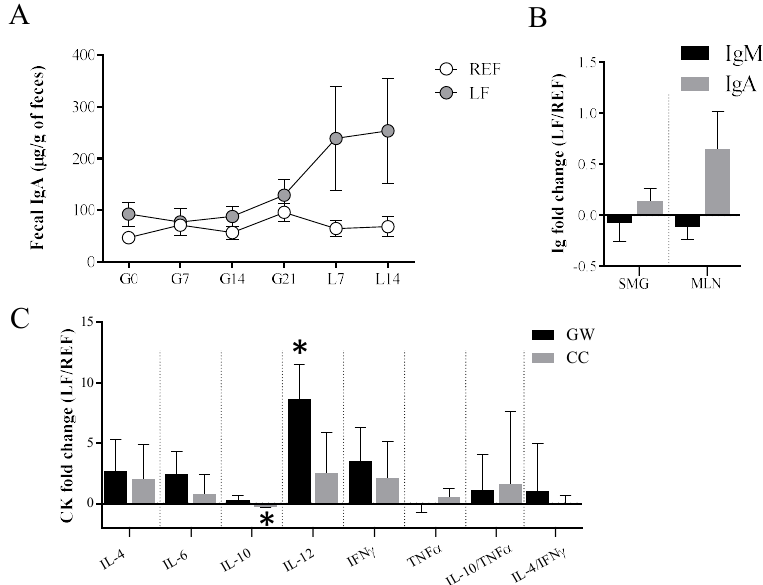
Figure 2. Mucosal immunoglobulins and cytokines of dams at L14. On the one hand, the evolution of ( A ) fecal IgA concentration was assessed throughout the study by ELISA. On the other hand, ( B ) the IgM and IgA were determined in submaxillary gland and mesenteric lymph nodes by ELISA at L14. Finally, ( C ) the concentration of cytokines in the gut wash and cecal content were analyzed by Luminex Technique at L14. Results are expressed as mean ± S.E.M. ( n = 6 / group). The fold change was calculated with respect to REF group. REF, reference group; LF, Lactobacillus fermentum CECT5716 group; Ig, immunoglobulins; SMG, submaxillary glands; MLN, mesenteric lymph nodes; CK, cytokines; GW, gut wash; CC, cecal content. * p < 0.05 compared to